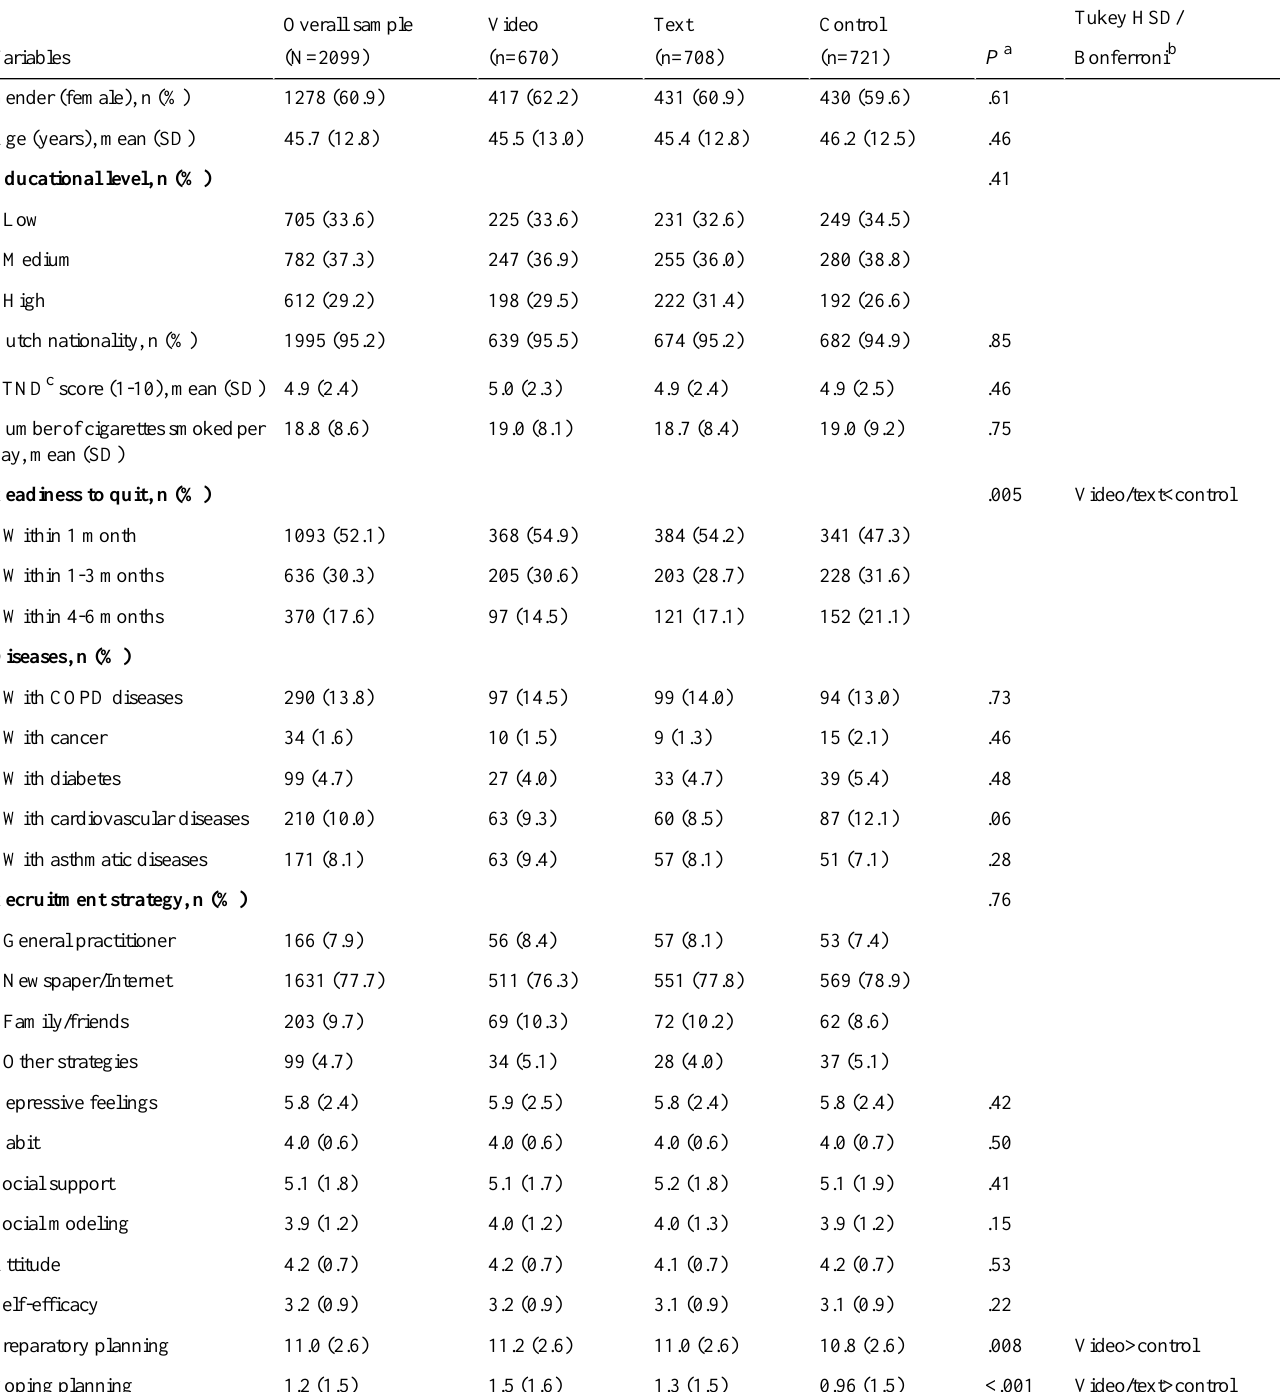
Table 1. Baseline sample characteristics for the video-based computer tailoring (video), text-based computer tailoring (text), and control conditions (recruited between December 2010 and June